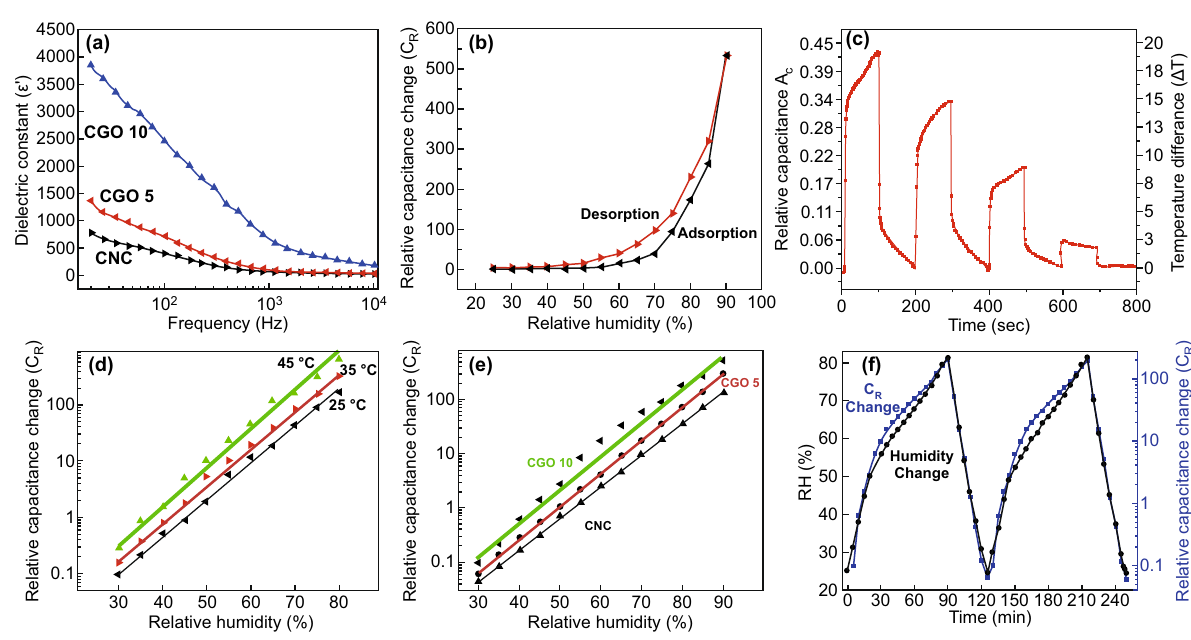
Fig. 20 a Dielectric behavior of NCs-GO/rGO hybrid film with frequency variation. b Absorption–desorption behavior and humidity hysteresis of NCs-GO/rGO hybrid film. c NCs-GO/rGO hybrid film temperature sensitivity limit by relative capacitance changes. d – f Relative capacitance change ( C R ) of NCs-GO/rGO hybrid film with different temperatures, RH, and time. Reproduced with permission from Refs. [31, 34]. Copyright © 2015, 2016 Elsevier